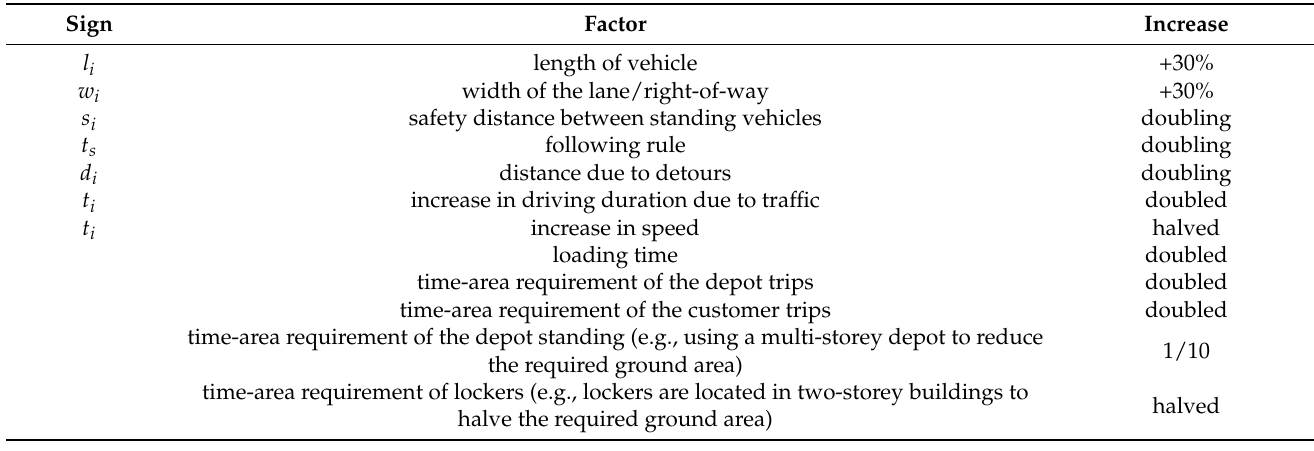
Table 3. Factors varied in the sensitivity analysis.